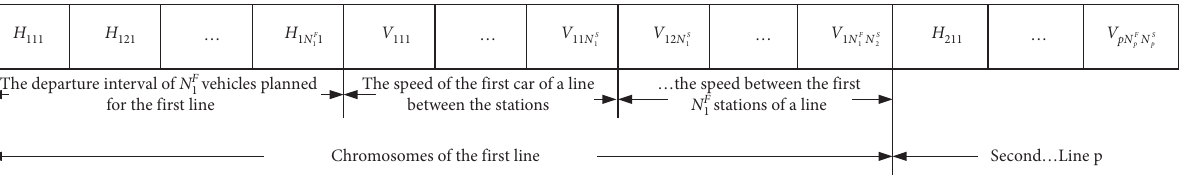
Figure 5: Schematic diagram of low-level heuristics